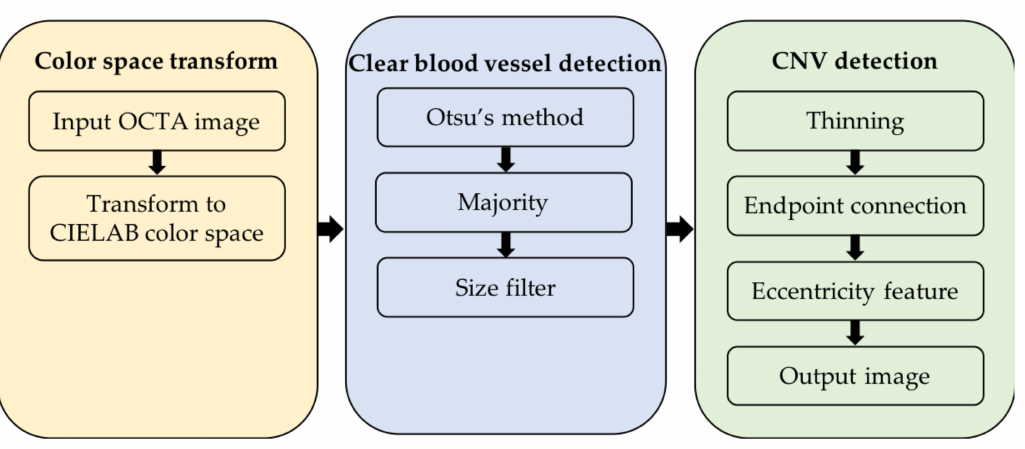
Figure 1. Flowchart of the proposed method. OCTA: optical coherence tomography angiography; CNV: choroidal